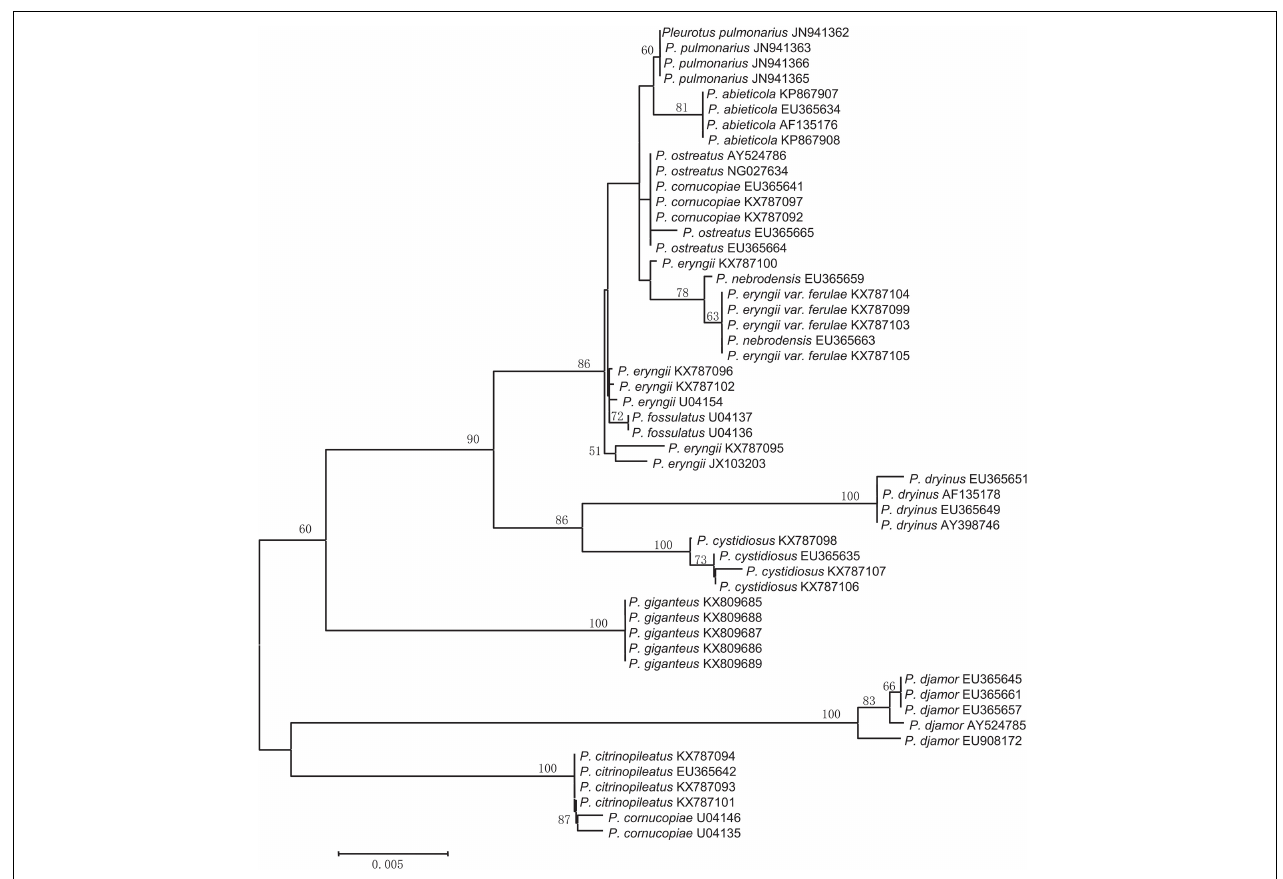
FIGURE 3 | Neighbor-joining tree based on the 28S rDNA sequences from the Pleurotus species.